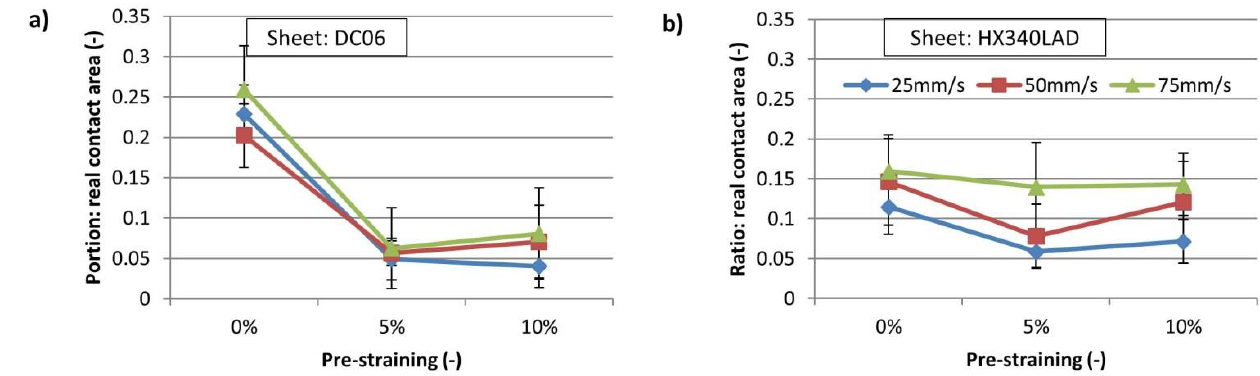
Figure 18. Portion of real contact area with variable sliding speed under the pressure 2.5MPa: ( a ) DC06; ( b ) HX340LAD.